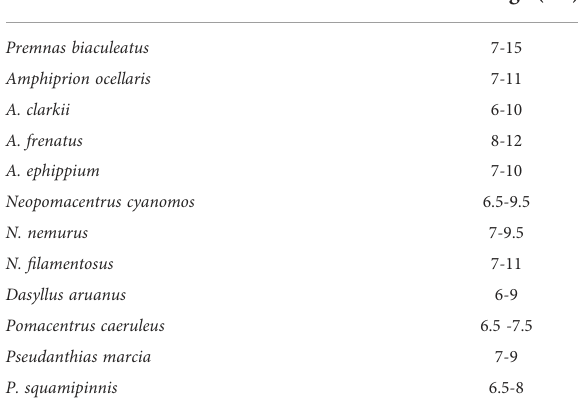
TABLE 2 Size range of brooders.